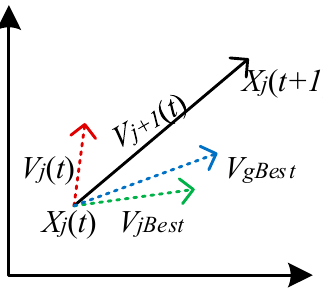
Figure 2. Particle position update by combination of velocity vectors.